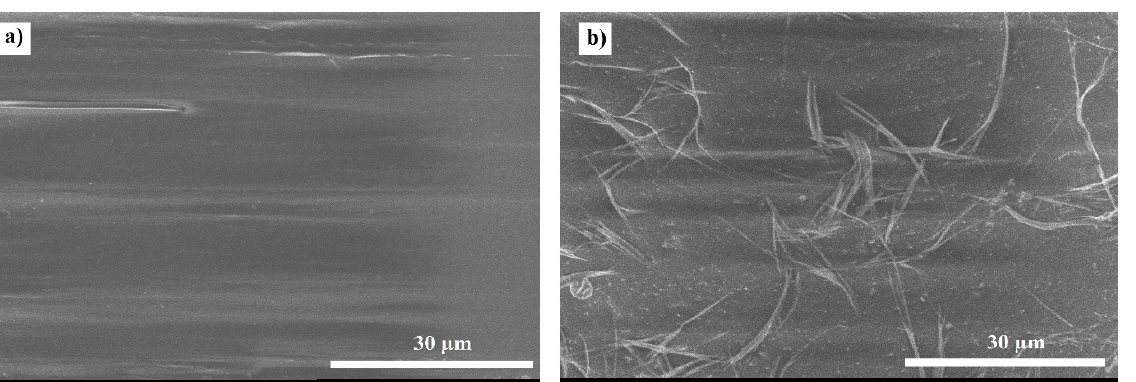
Figure 3. Surface morphology of the stents: ( a ) non−degraded, ( b ) 4−weeks−degraded, ( c ) 8−weeks−degraded, ( d ) 16−weeks−degraded and ( e ) 24−weeks−degraded stent. The AFM measurements of the top surface revealed the material topography at the nanoscale and gave evidence of the top surface roughness. As can be seen in Figure 4, the 24-weeks-degraded surface is significantly disrupted and furrowed by deep cracks.